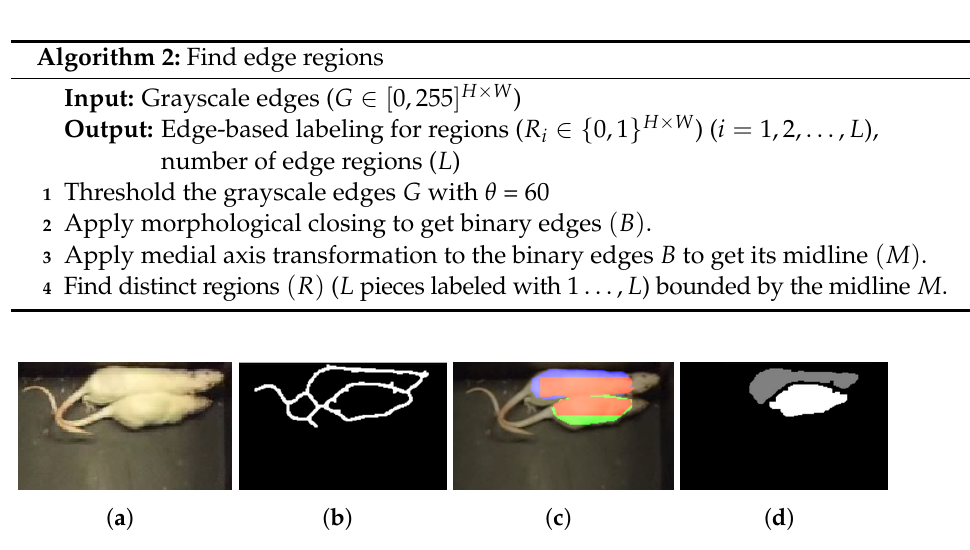
Figure 7. Initial labeling. ( a ) Grayscale input image ( b ) Dilated midline of the detected edges ( c ) Body parts prediction with initial labels shown by different colors ( d ) initial labels from ( b ). ( c , d ) are used for further segmentation steps in Algorithm 3.